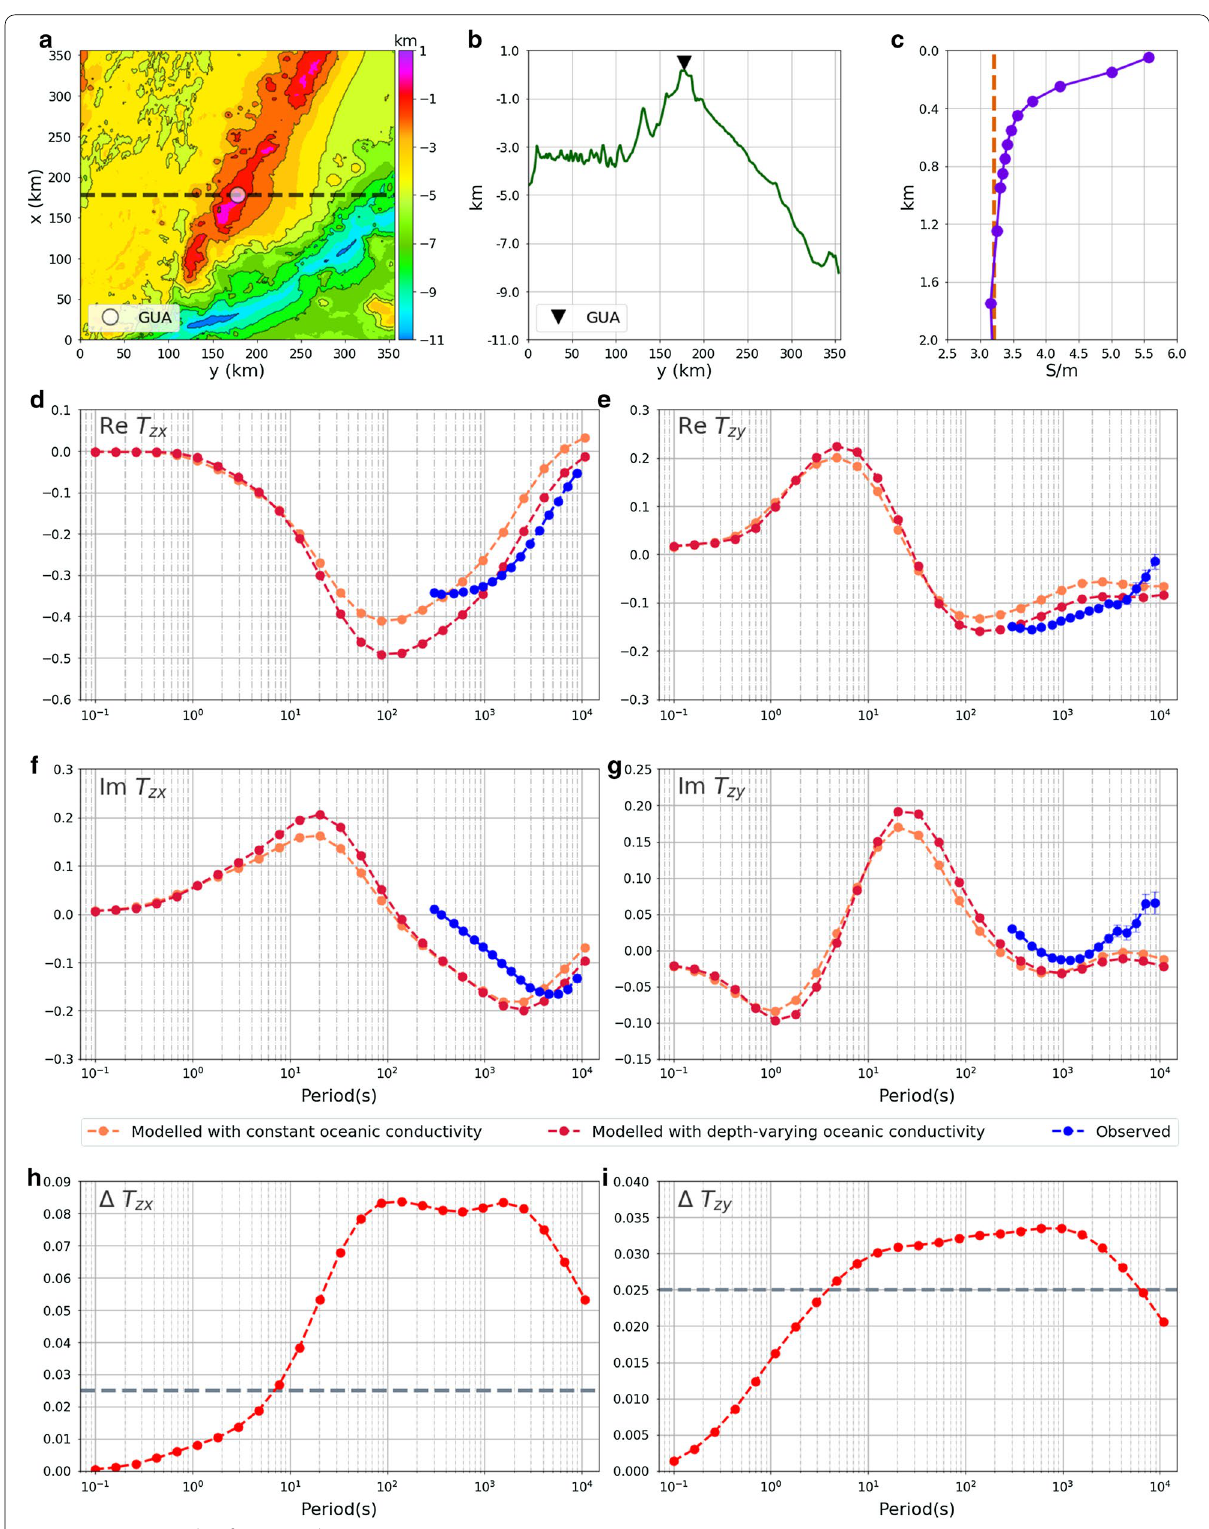
Fig. 9 Same as Fig. 5, but for Guam observatory